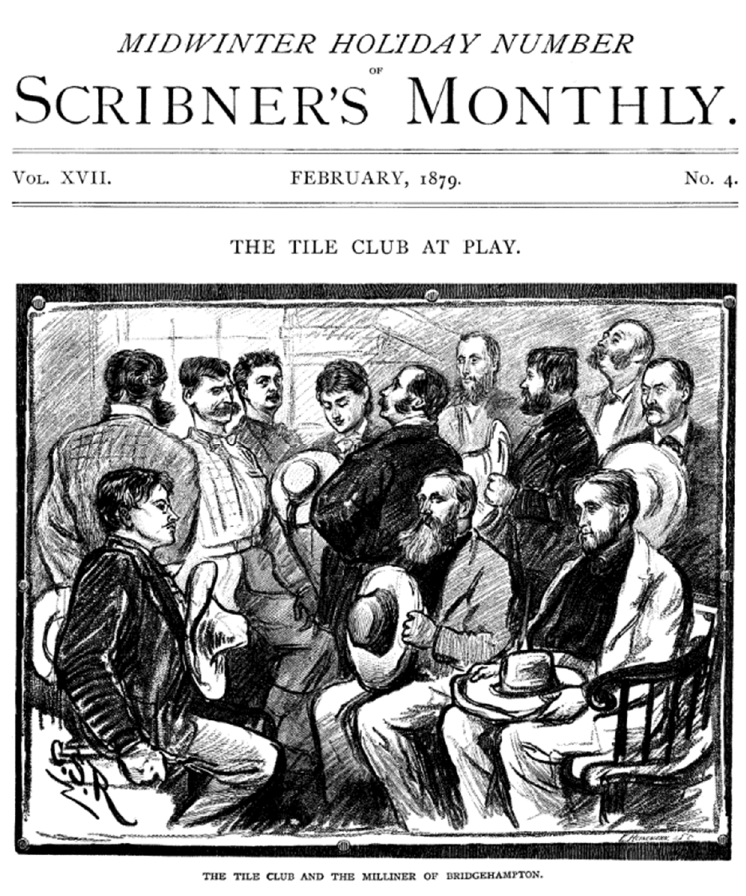
Figure 13. Title page of Midwinter Holiday Number of Scribner’s Monthly , February 1879, and opening illustration for “The Tile Club at Play”, featuring engraving after a drawing by Charles S. Reinhart, The Tile Club and the Milliner of Bridgehampton. Hathi Thrust Public Domain resources.